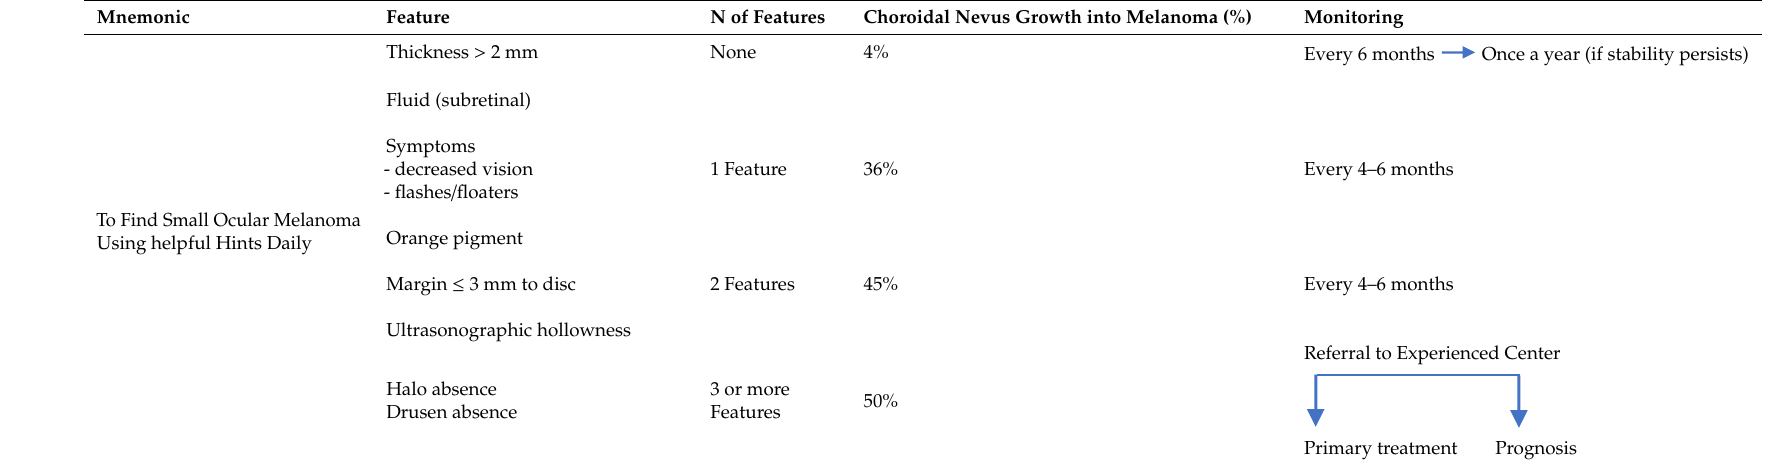
Table 1. Features predicting malignant transformation of choroidal nevus into melanoma are listed in the mnemonic ”TFSOM UHHD ‘to find small ocular melanoma using helpful hints daily’”. The percentages of choroidal nevus growth into melanoma based on number of involved features are reported along with recommended clinical monitoring [20,21].